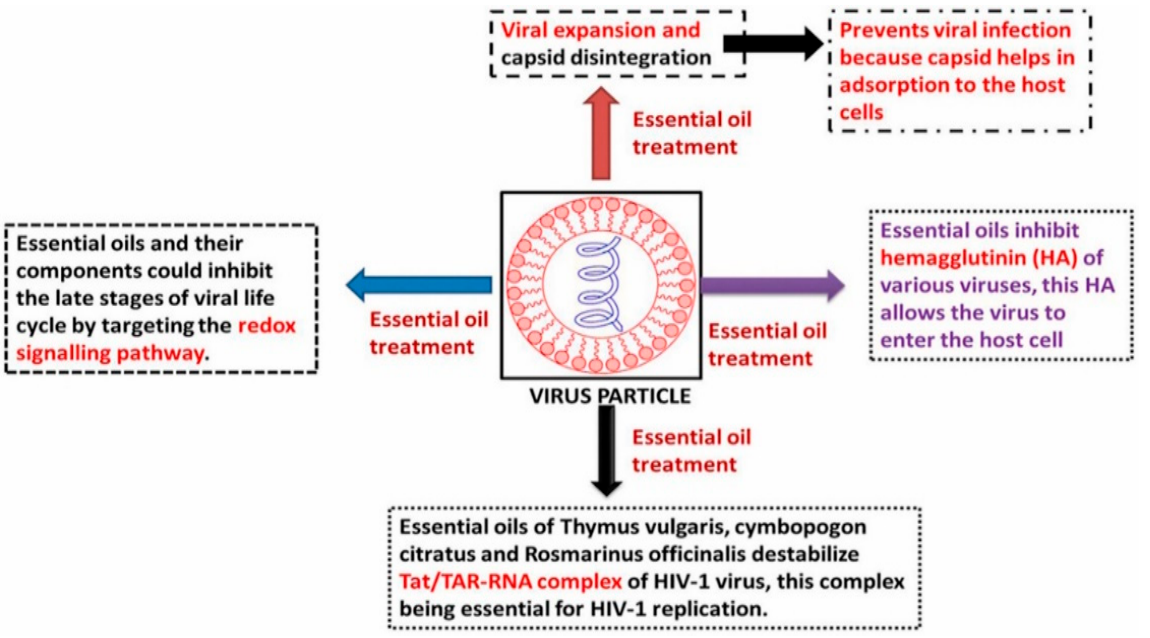
Figure 3. Proposed mechanism of action of various essential oils for anti-viral activity.